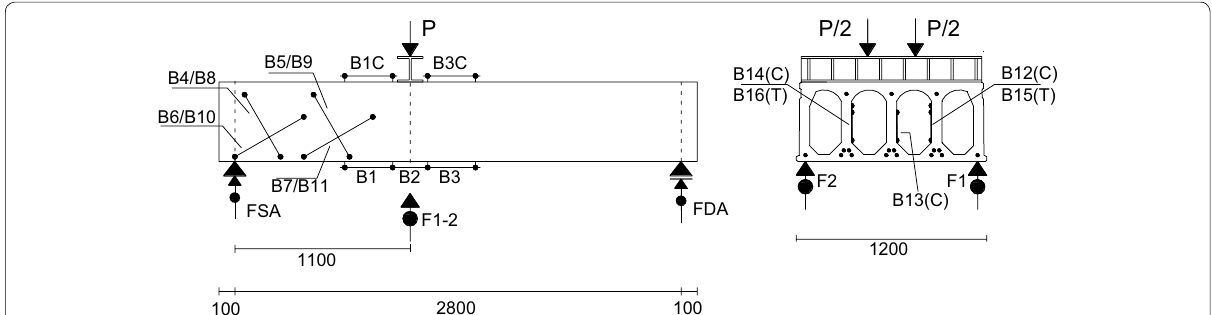
Fig. 6 Shear tests on specimens H50-s1 and H50-s2: sketch of the loading arrangement and of the instrumentation adopted for the measuring of strains and vertical displacements (dimensions in mm).